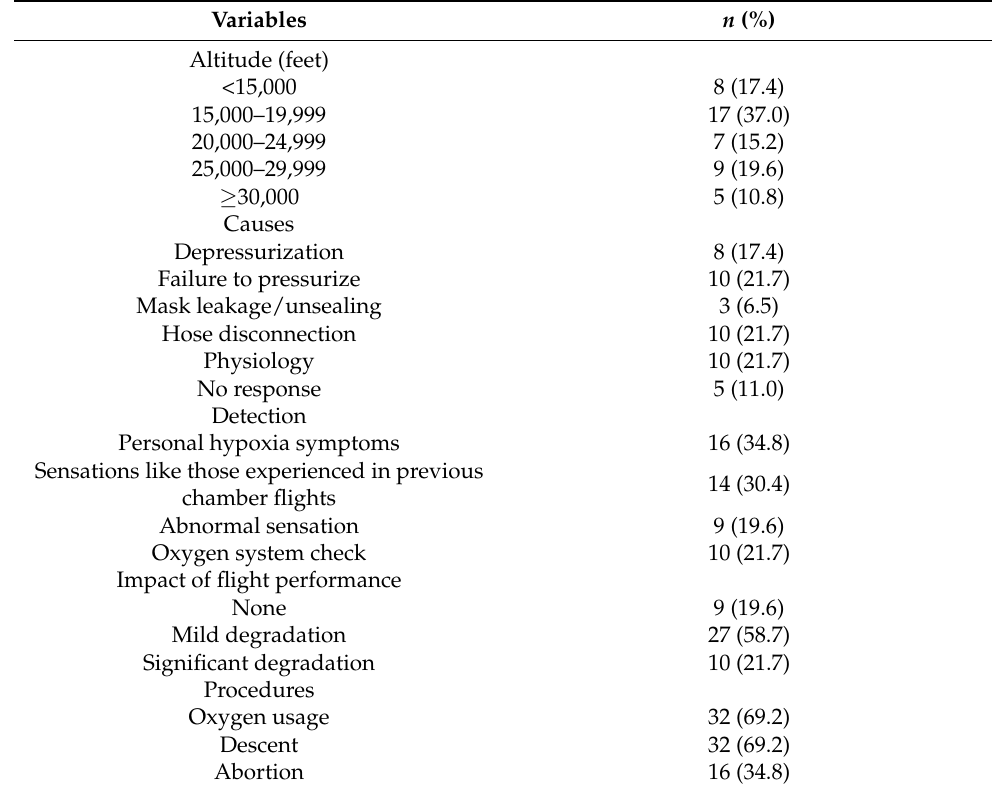
Table 2. Characteristics of inflight hypoxia events.